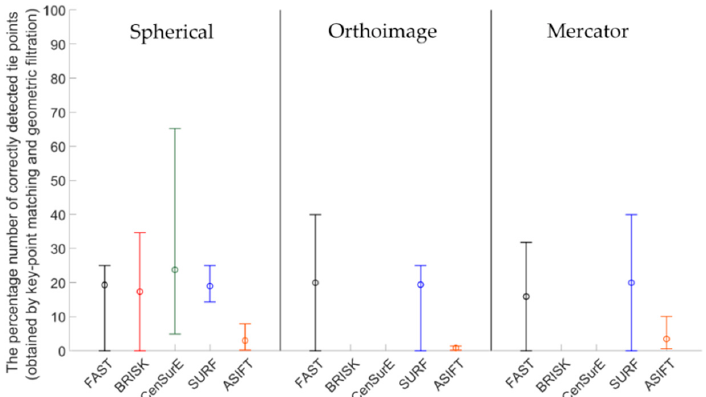
Figure 13. Diagram of the percentage mean (circles), maximum, and minimum number of correctly detected and matched key points using blob (ASIFT, SURF, and CenSurE) and point (FAST and BRISK) detectors for rasters in the spherical projection, orthoimages, and the Mercator projection; Test Site IV.